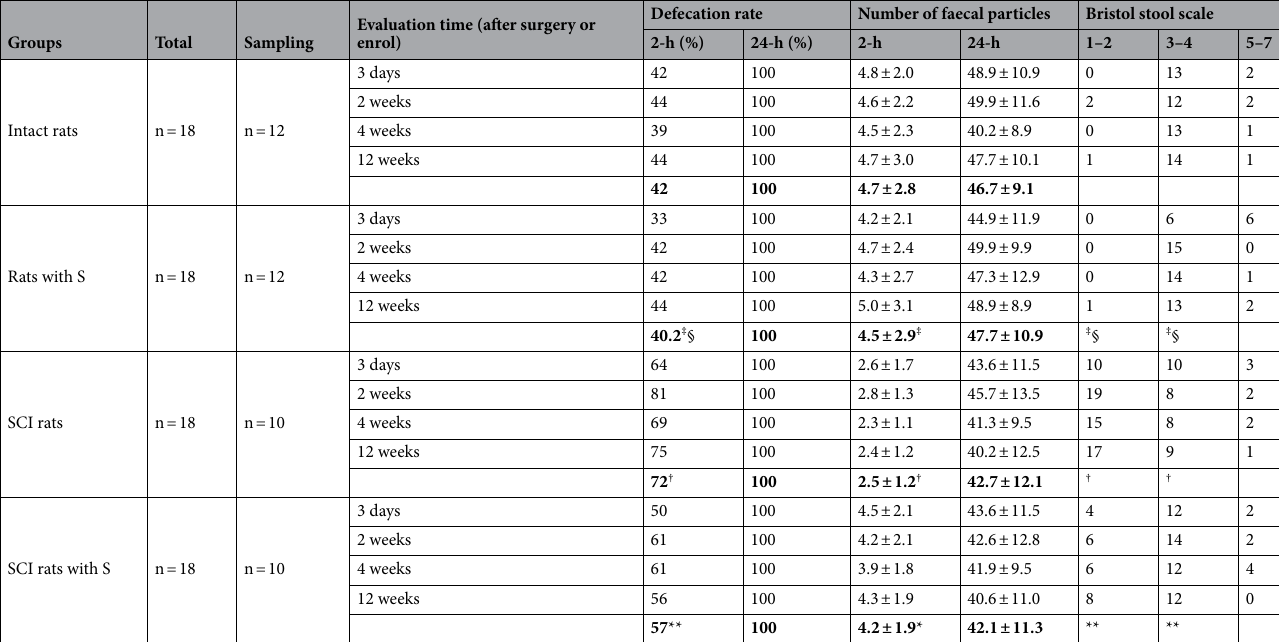
Table 1. Ratings of constipation. Defecation rate, the percentage of defecation rats during a given period. Bold type, the average of the four time points. *p < 0.05, comparison between SCI Rats with S and SCI Rats; **p < 0.05, between SCI Rats with S and Intact rats; † p < 0.05, between SCI Rats and Intact Rats; ‡ p < 0.05, between Rats with S and SCI Rats; § P < 0.05, between Rats with S and SCI Rats with S (Chi-square test or two- way